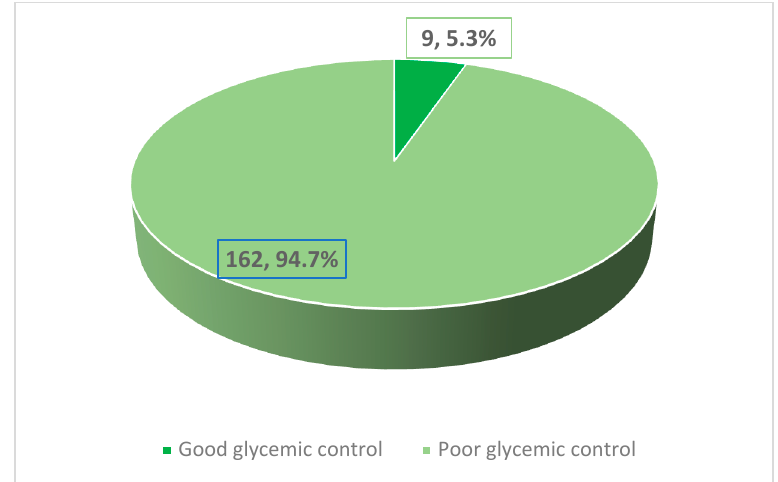
Figure 1. Prevalence of uncontrolled type 1 diabetes mellitus among children in the Aseer Region. Among the studied factors related to diabetes, only diabetes management and dis- ease duration (Table 2) appeared to be significant: (1) use of carbohydrate counting; ap- proximately 81.8% of children who used carbohydrate counts had high HbA1c levels ( ≥ 7.5%), compared to 96.6% of children who did not ( p = 0.017); and (2) duration of disease; roughly 91.5% of children with a disease duration of 3 years or less had high HbA1c levels ( ≥ 7.5%), compared to 98.7% of those with a disease duration exceeding 3 years ( p = 0.035).